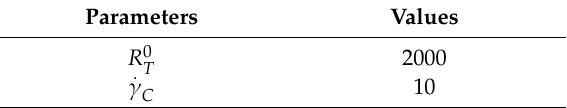
Table 3. The parameters for the revised IISO model in flow–fiber coupling calculation.